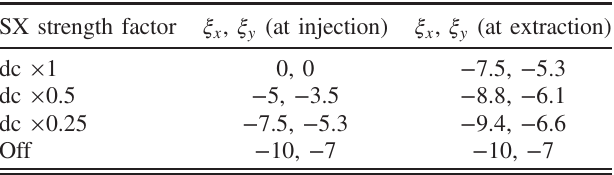
TABLE V. The degree of SX dc field strength factor versus horizontal ( ξ x ) and vertical ( ξ y ) chromaticities at the injection and extraction energies. The “ SX dc × 1 ” here is same as the “ SX dc ” shown in Fig. 10 and stated throughout the text.